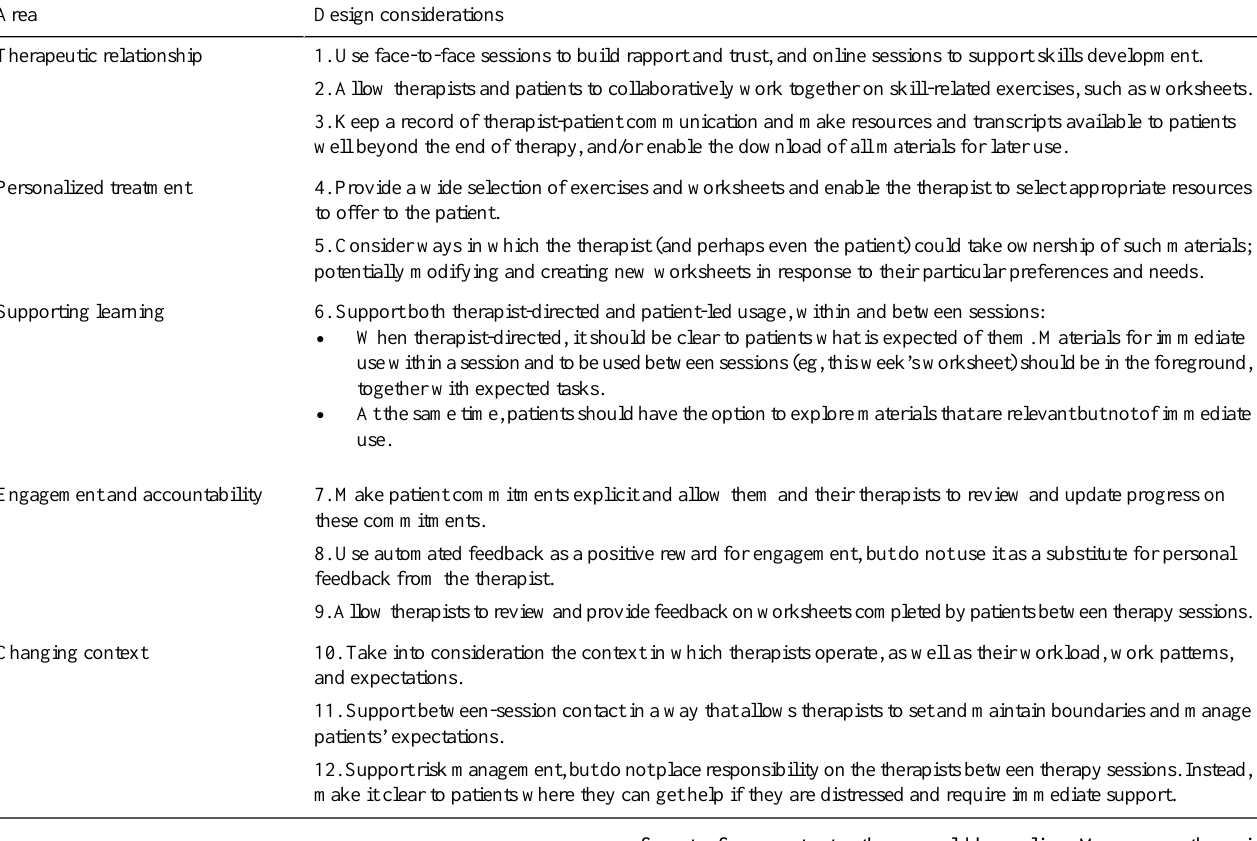
Table 1. List of design considerations for blended systems that aim to further integrate online resources and contact with a therapist. Design